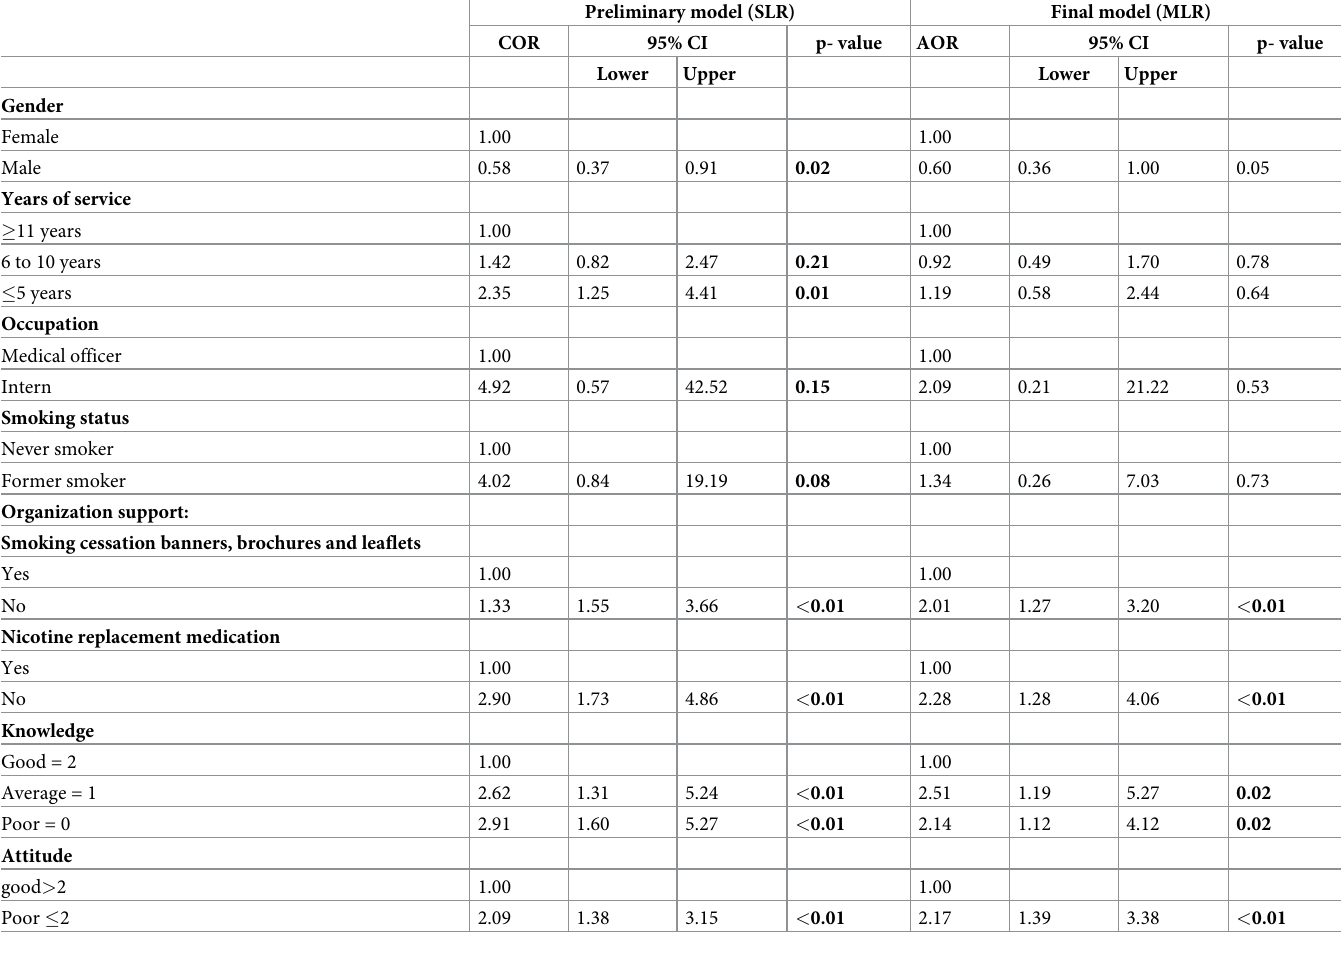
Table 4. Factors associated with the practice of smoking cessation management at precontemplation phase among primary health care